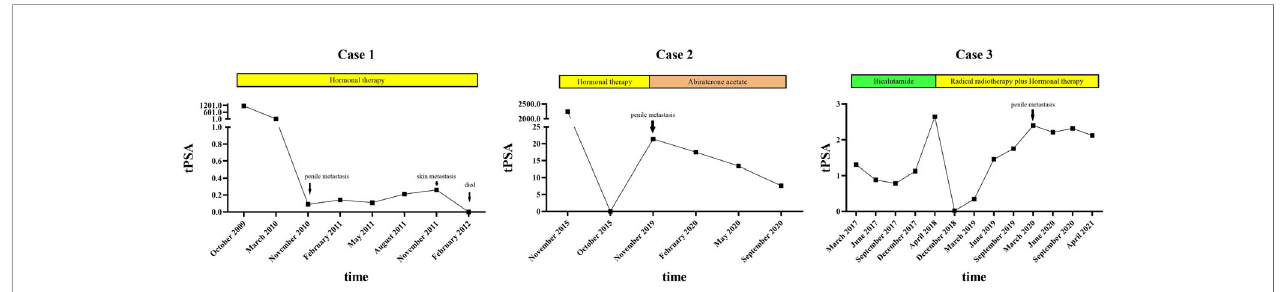
FIGURE 3 | A timeline with relevant data of the 3